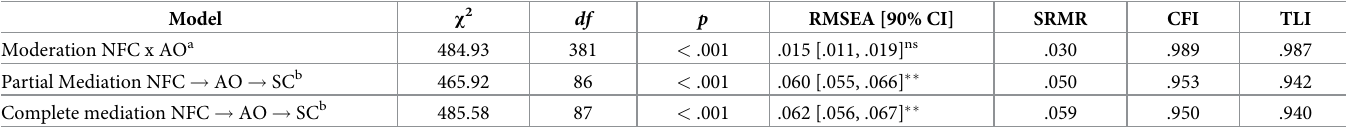
Table 2. Fit statistics for mediation and moderation models to predict